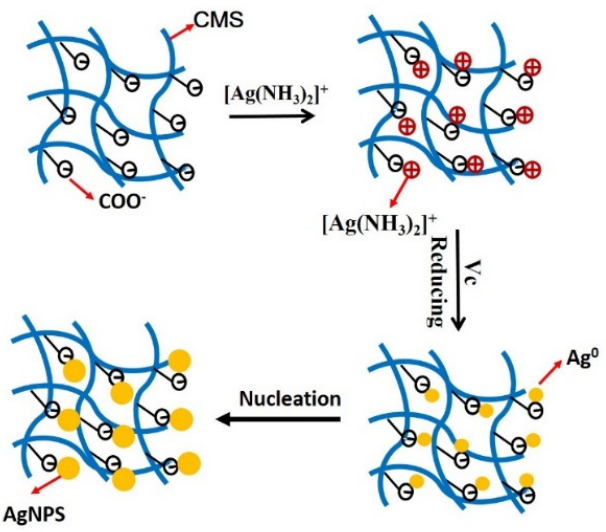
/ AgNPs synthesis.